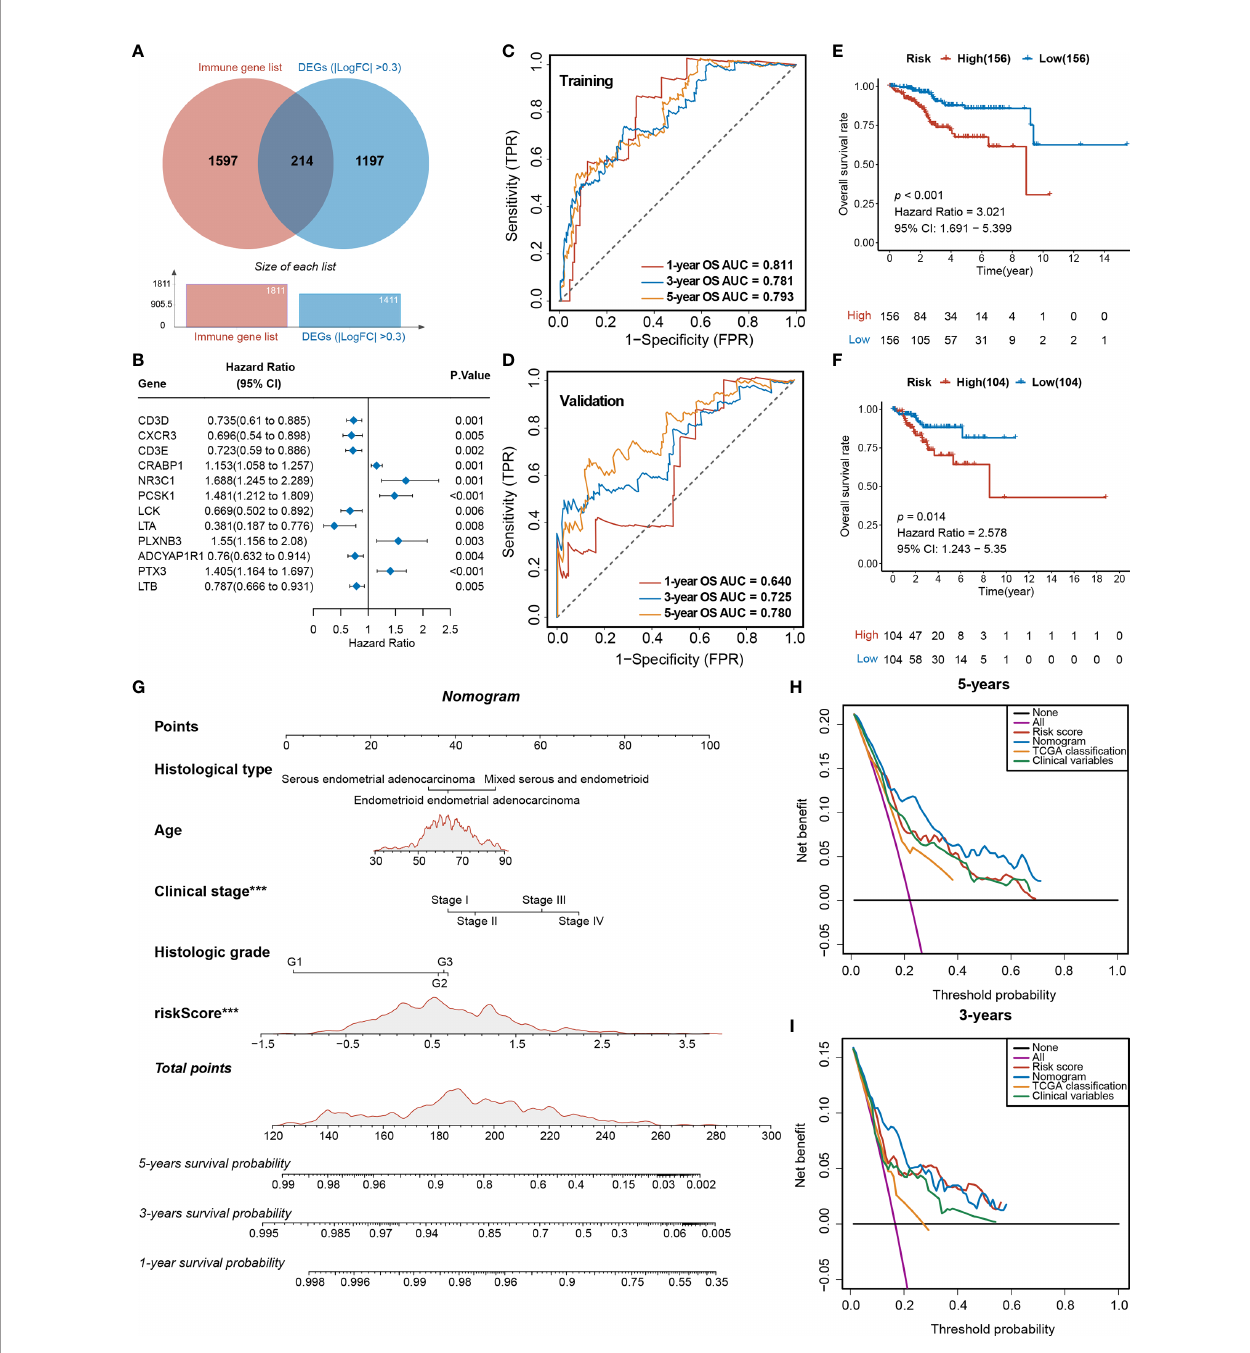
FIGURE 5 | Analyses of the DEGs and development of the TIRM based on immune-related DEGs of Tfh in fi ltration. (A) Venn diagram depicts the overlap of the genes involved in immune genes and DEGs of Tfh in fi ltration. (B) Forest plot of the univariate analyses for seven signi fi cant immune-related DEGs of Tfh in fi ltration with overall survival ( p < 0.01). (C) ROC curve of the prognostic values of TIRM training group in 1-, 3-, and 5-year OS with AUC = 0.811, 0.781, and 0.793, respectively. (D) ROC curve of the prognostic values of TIRM validation group in 1-, 3-, and 5-year OS with AUC = 0.640, 0.725, and 0.780, respectively. (E, F) Kaplan – Meier curve of the overall survival for patients in the Tfh-based high-risk and low-risk subgroups in the training group (E) and validation group (F) ( p < 0.001 and p = 0.014, respectively). (G) A newly constructed nomogram including clinical characteristics of age, histological type, stage, grade, and risk score of Tfh in the nomogram. Each of these factors generates points according to the axes drawn upward. The total score of these components for each patient is located on the “ total score ” axis, which corresponds to the 1-, 3-, and 5-year OS probabilities plotted on the lower two axes. *** p < 0.001. (H, I) Net DCA curves show the net bene fi ts of the nomogram at 5-year (H) and 3-year (I) OS, and the y -axis measures the net bene fi t. The nomogram has a higher net bene fi t compared to risk score, TCGA classi fi cation, and combined (histological type + stage + grade) and simple strategies such as follow-up of all patients (purple line) or no patients (horizontal black line) across the full range of threshold